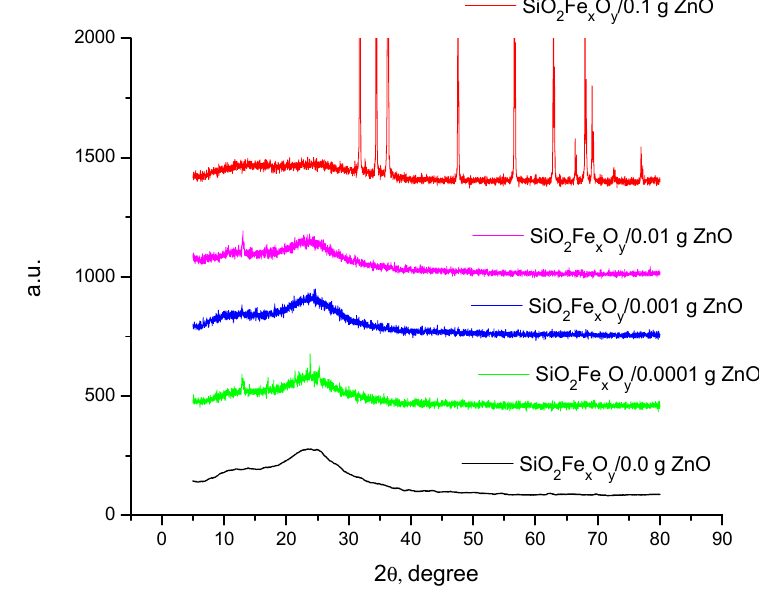
Figure 3. Recorded XRD spectra.